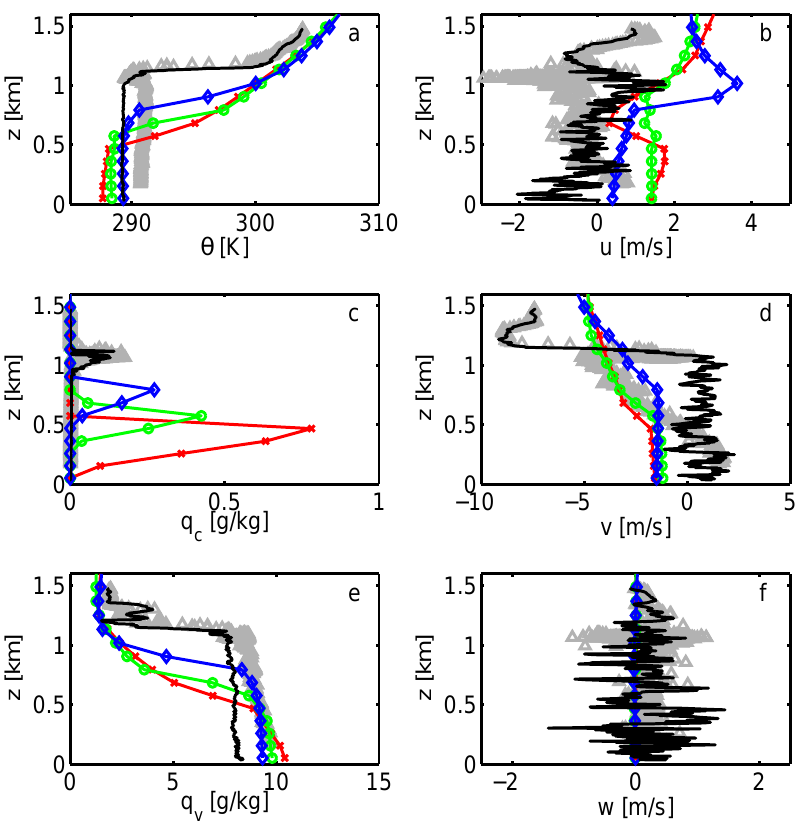
Fig. 3. Model sensitivity to the boundary layer parametrizations for the run with 81 vertical levels and for profile 2; black line – observations, blue – REF, green – SF1, red – SF2; gray points – variability of measurements.